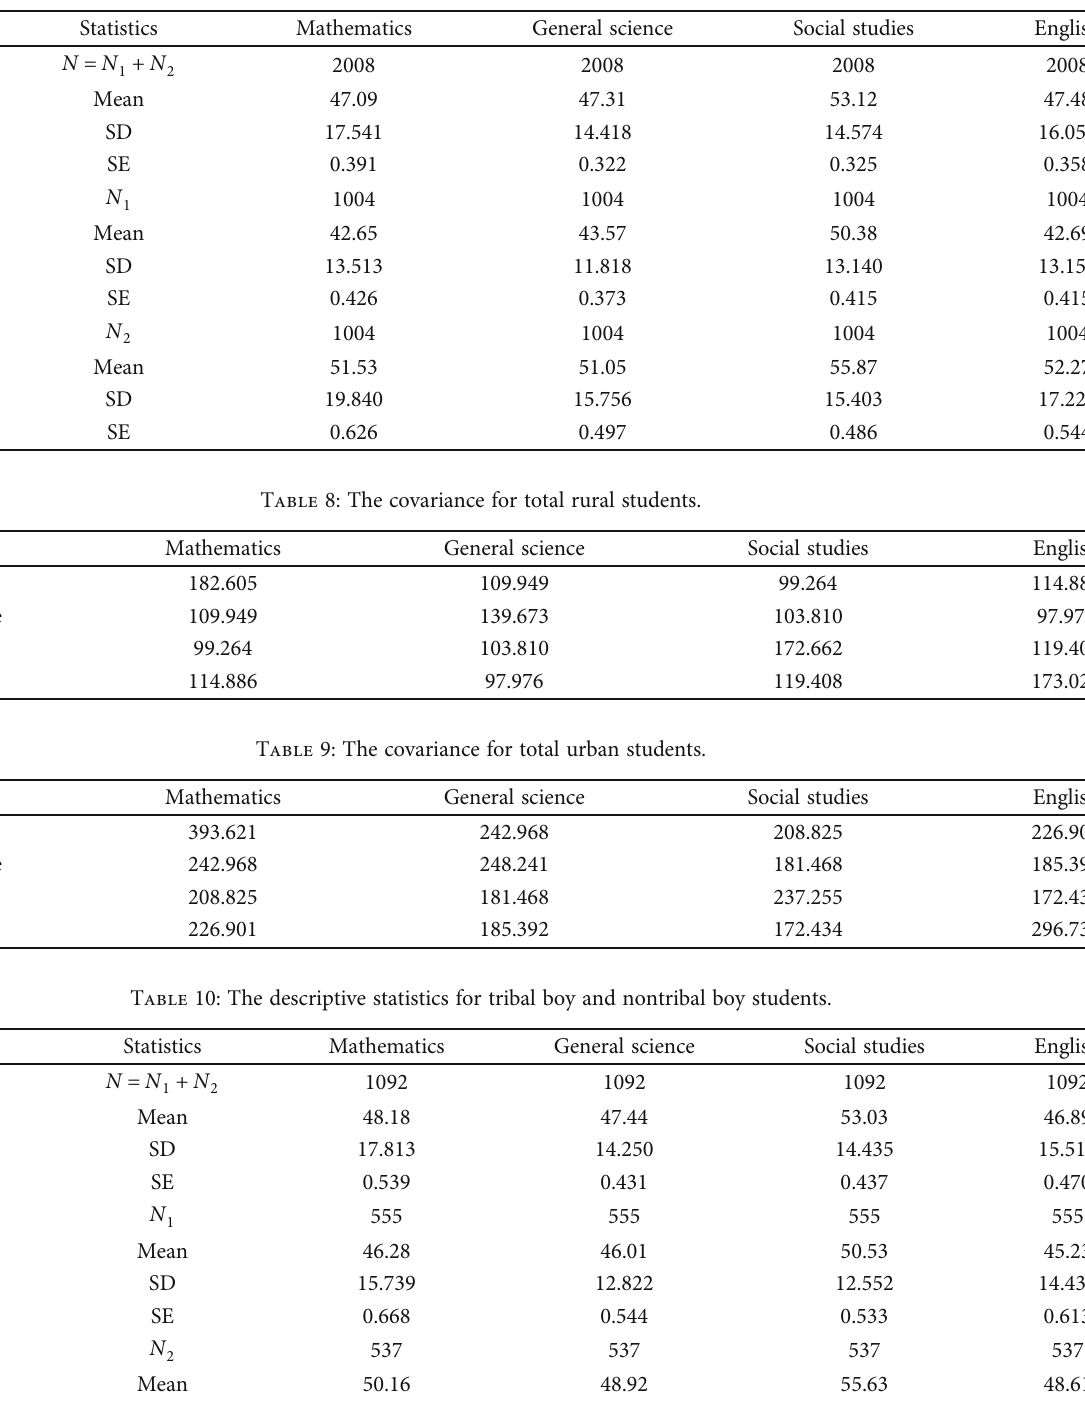
Table 7: The descriptive statistics for total rural and urban students.